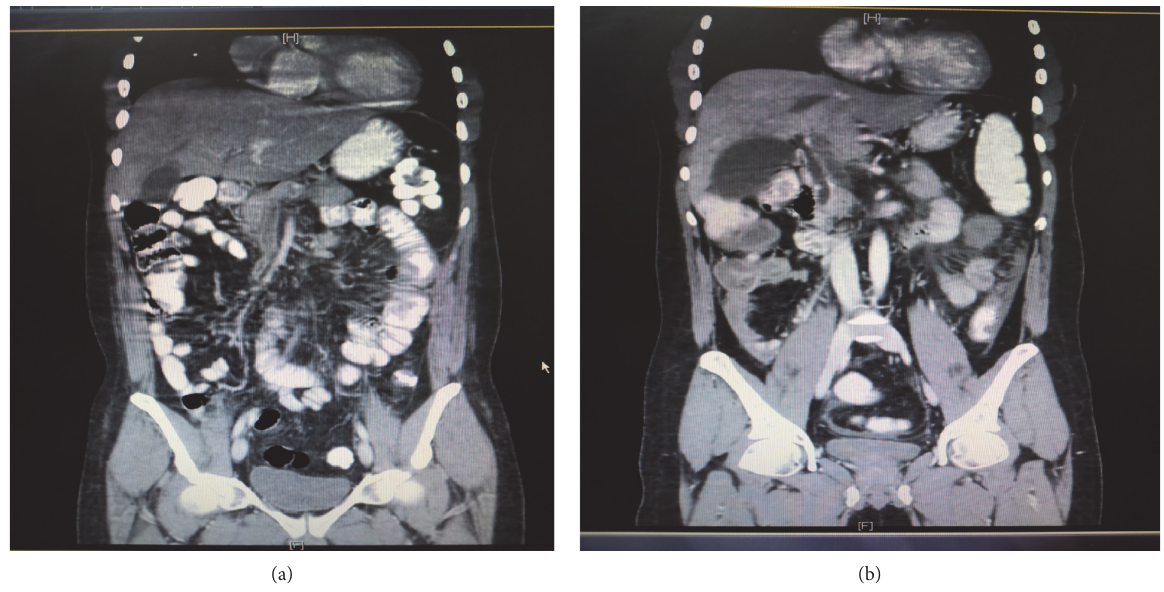
Figure 3: CT abdomen with IV contrast showing mesenteric vein thrombosis and thickening of the small bowel with skipped lesions.